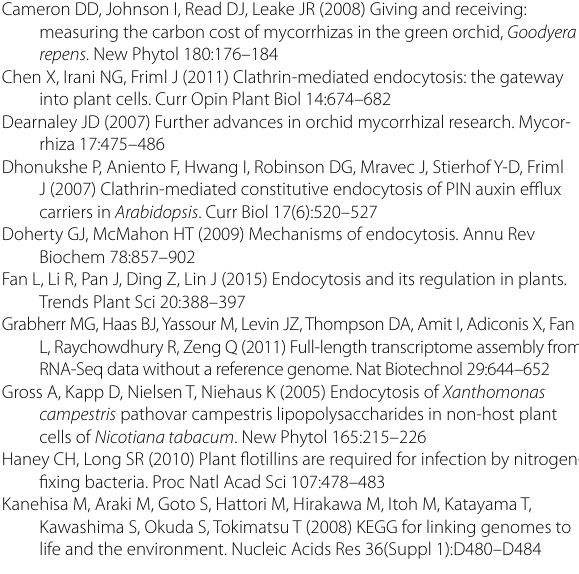
Additional file 1: Figure S1. Characteristics of similarity search of unigenes against NR database. Figure S2. GO classification of all unigenes from RNA-Seq. Figure S3. KOG classification of all unigenes from RNA-Seq. Figure S4. KEGG pathway enrichment scatter diagram of all unigenes from RNA-Seq. Figure S5. Correlation of RPKM distribution between two biological replicates. Table S1. The quantitative PCR prim- ers of putative genes. Table S2. Statistical summary of sequences analysis. Q20 and Q30: The percentage of bases with a Phred value > 20 and